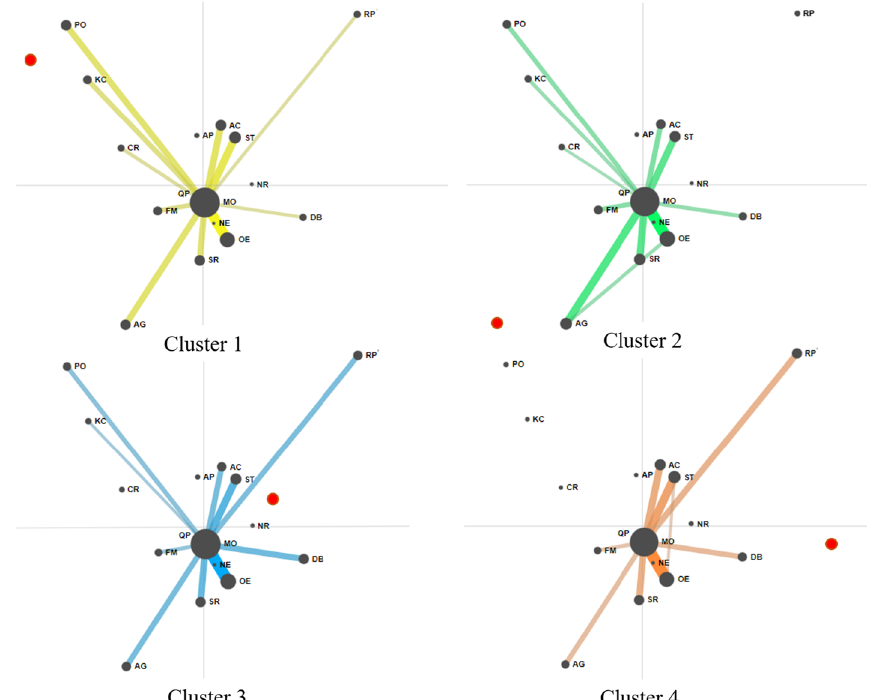
Fig. 4 The epistemic network analysis of four collaborative clusters. The threshold of edge weight in the epistemic networks was set as 0.25 to show the representative connections and structural characteristics (i.e., connection value 0.25) among the verbal communication, operational behavior, and facial expression ≥ dimensions